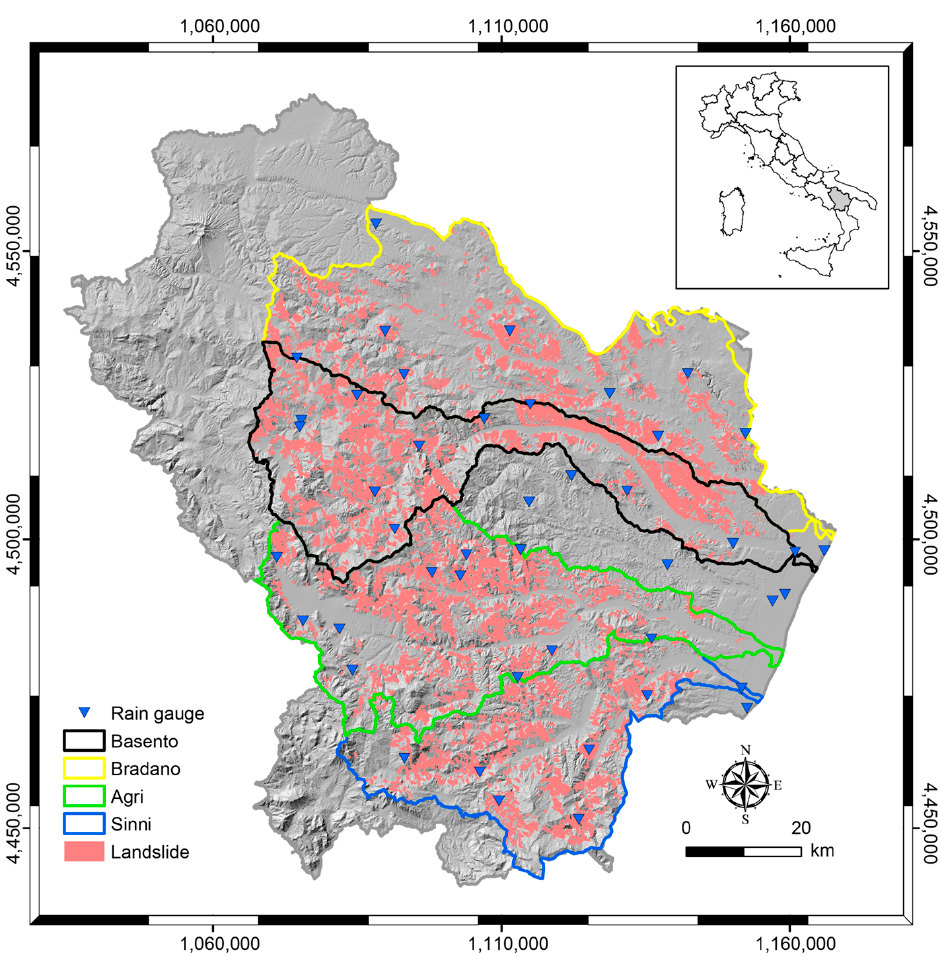
Figure 1. The inset shows the location of the Basilicata region. The main map shows the Basento, Bradano, Agri and Sinni River catchments. Landslides from the inventory of landslide phenomena in Italy (pink polygons) and rain gauges (blue triangles) used for rainfall analyses are also shown.